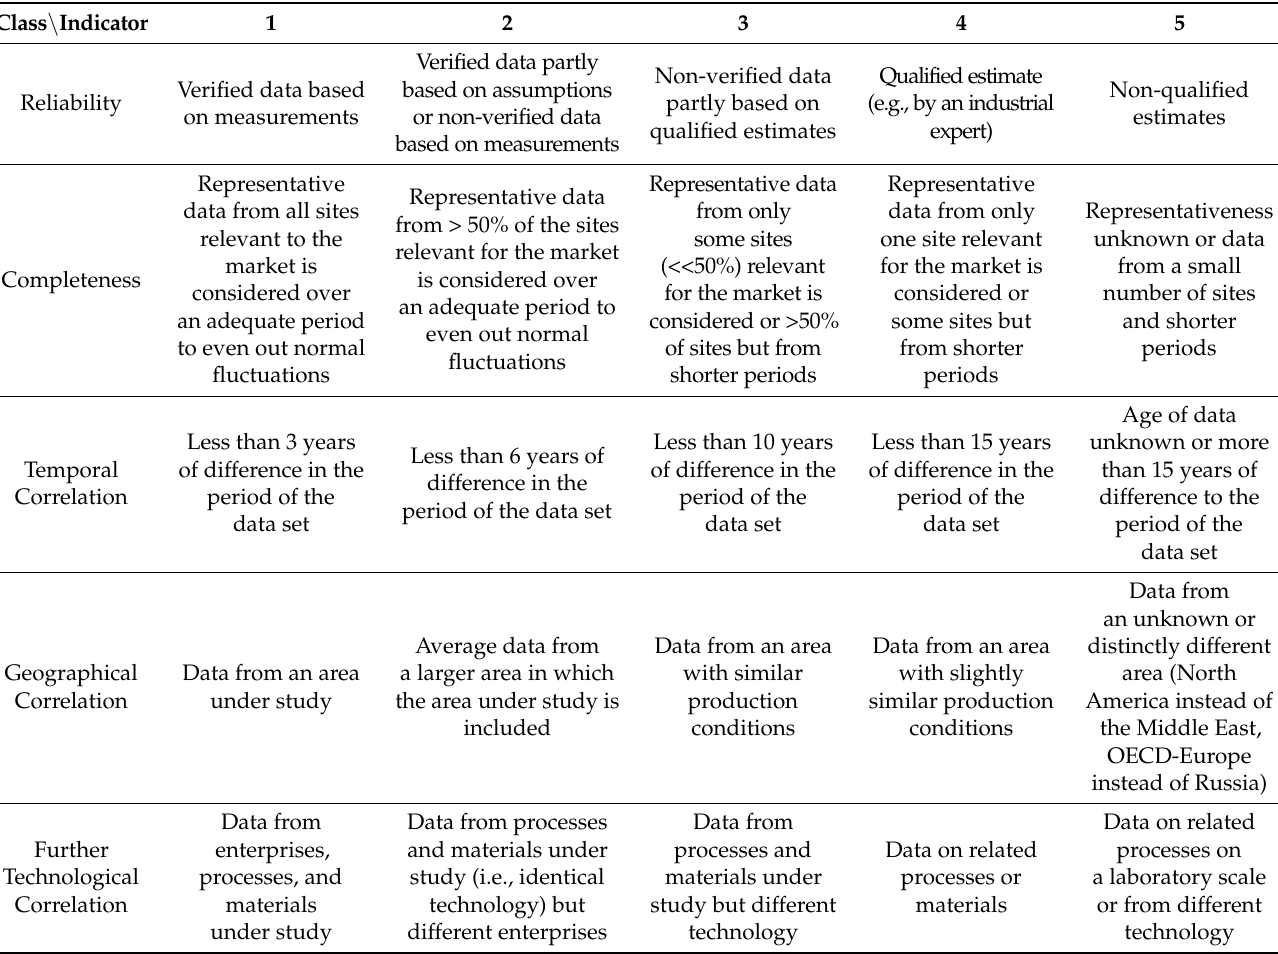
Table 5. Description of each quality class and indicator according to Ecoinvent quality data